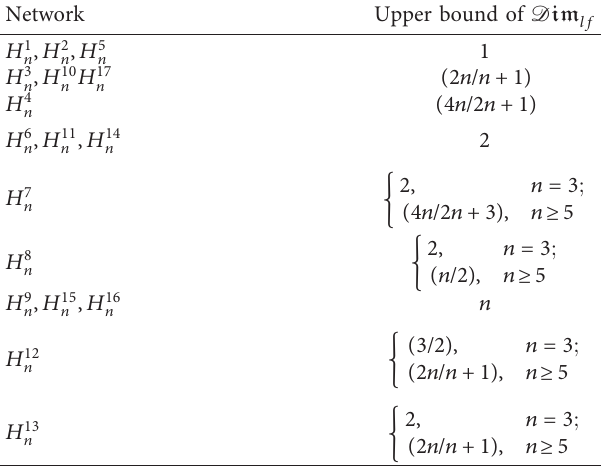
Table 1: Sequences of local fractional metric dimension of rota- tionally symmetric hexagonal planar